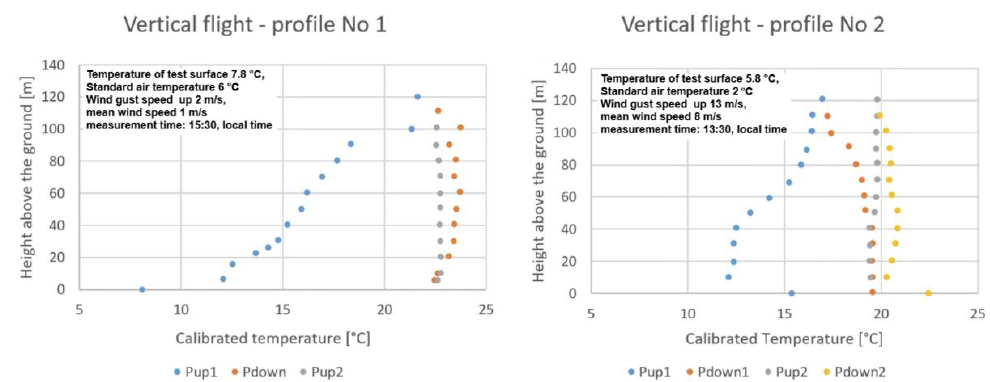
Figure 8. The temperature graphs of the reference surface obtained in the photos in vertical profiles up to a height of 120 m above this surface, in duplicate (profile-1: up/down/up; profile-2: up/down/up/down). The first profile was made on 4 January, and the second profile was made on 6 January 2022. For the first flight, no thermal images were taken during the second downhill series). Temperature determined by radiometric calibration equations.